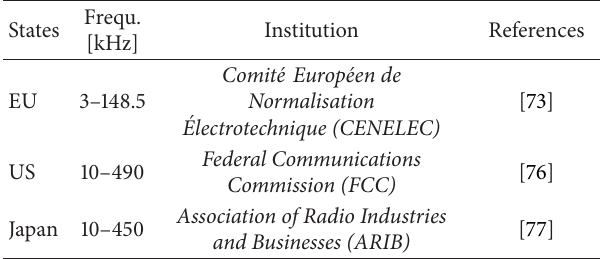
Table 3: Important regulations related to NB-PLC [75] © 2012 John Wiley &